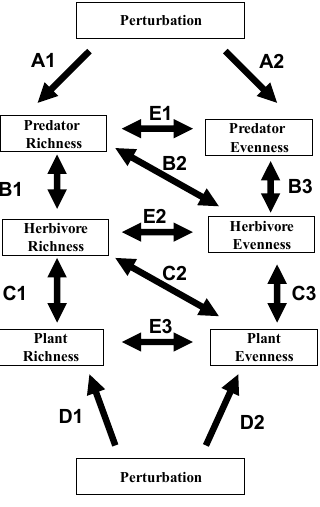
Figure 1. Selected diversity cascades. Double headed arrows indicate positive or negative effects of one variable on another. The letters next to the lines could be path coefficients or any effect size statistic. Perturbations could include changes to resources or upper trophic levels with a subsequent effect on the richness or evenness of predators or plants, respectively; perturbations could also be introduced to other trophic levels [27]. Paths going via D-C-B (including E) are bottom-up diversity cascades. For example, Pearson and Dyer [28] demonstrated that increased plant richness in grasslands leads to greater diversity of herbivores (C1), subsequently supporting higher diversity of carnivores (B1). Paths proceeding via A-B-C (including E) represent some of the possible top-down diversity cascades. Schmitz [29] showed that the presence or absence of a particular predator (A1) determined feeding patterns by herbivores on plants (B), thus strongly altering plant evenness patterns (C2). Several other possible diversity cascades (e.g., pathways from enemy evenness to plant diversity) are not depicted